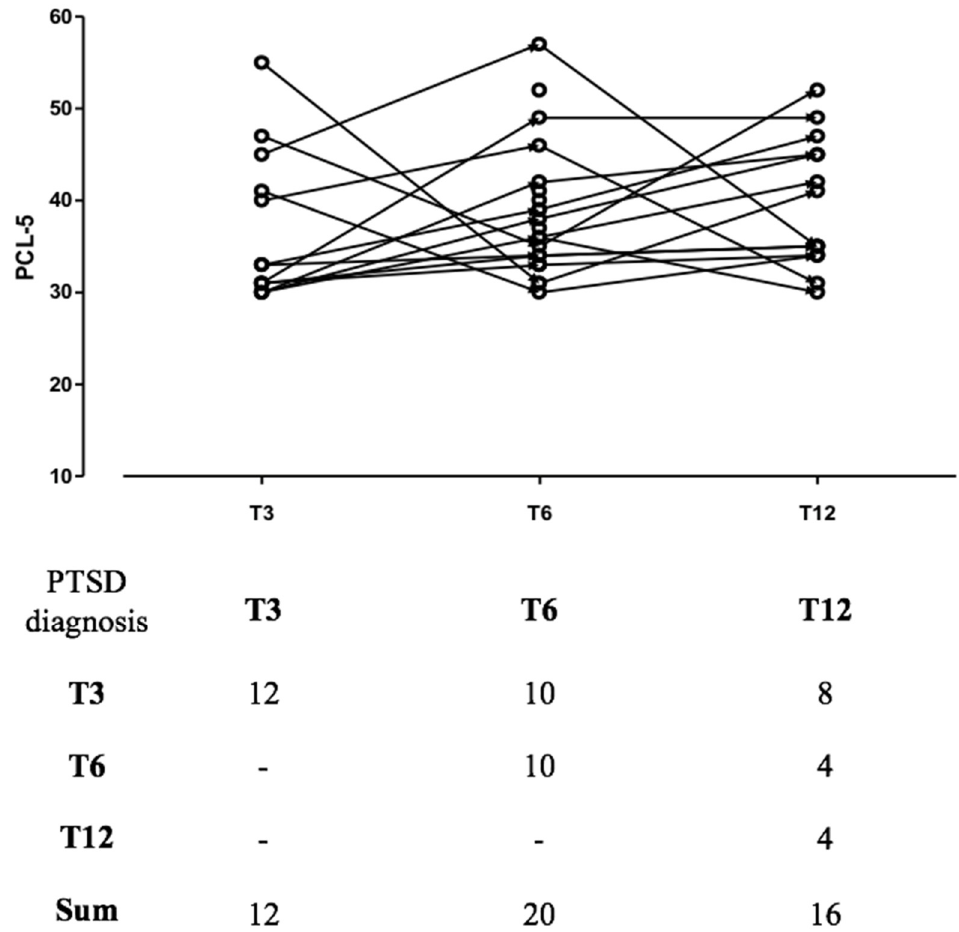
Figure 1. PCL-5 total score trajectories in patients without PTSD.